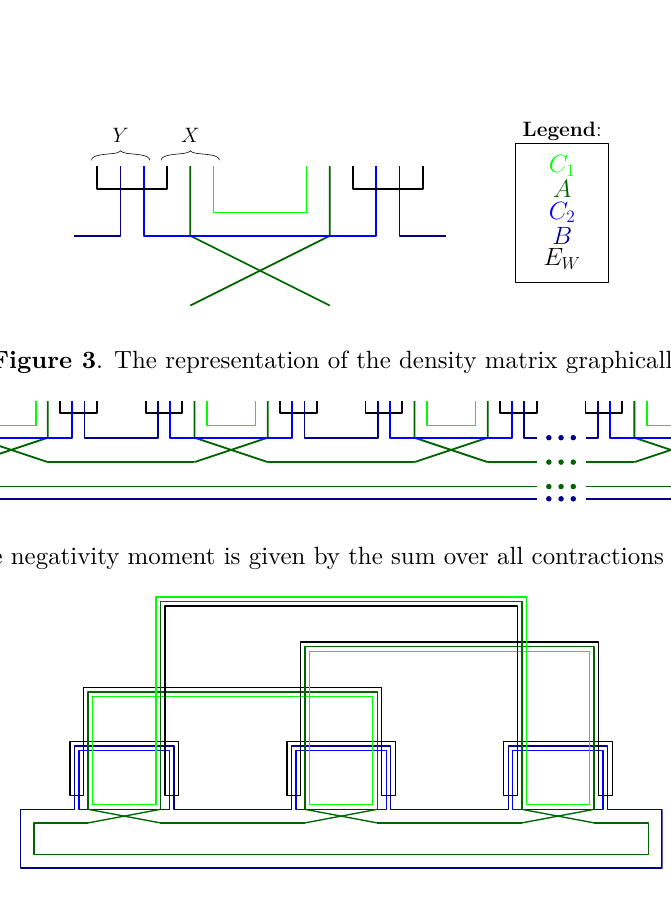
Figure 5 . A diagram contributing to the third negativity